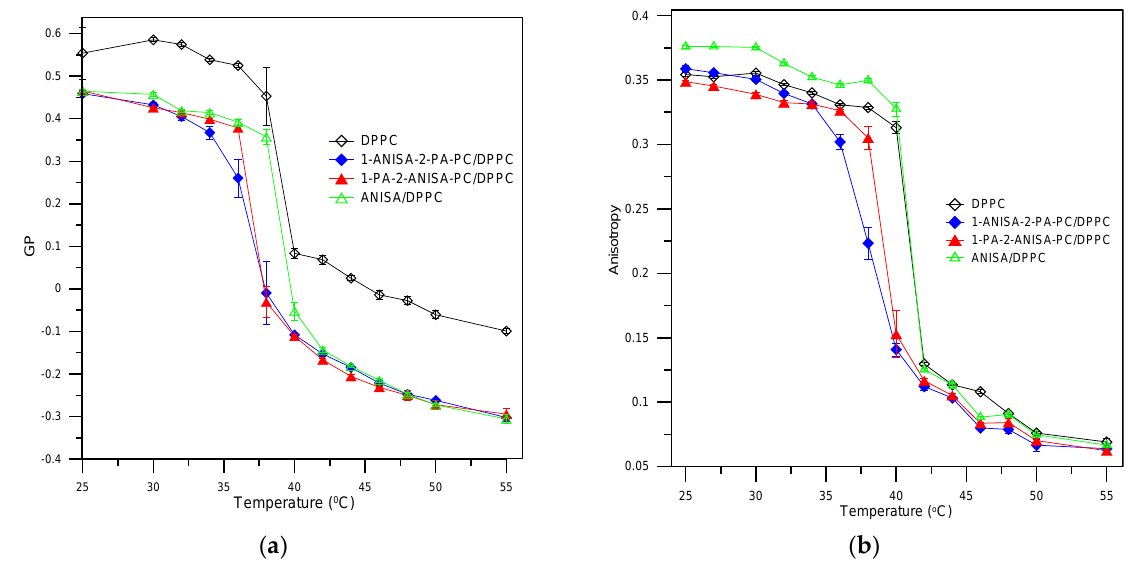
Figure 4. Values of general polarization (GP) of Laurdan in liposomes DPPC (control) and new forms of liposomes (tested probes) at molar ratio the conjugate:DPPC 1:5, as a function of temperature ( a ). Values of anisotropy of DPH in liposomes DPPC (control) and new forms of liposomes (tested probes) at molar ratio the conjugate:DPPC 1:5, as a function of temperature ( b ).